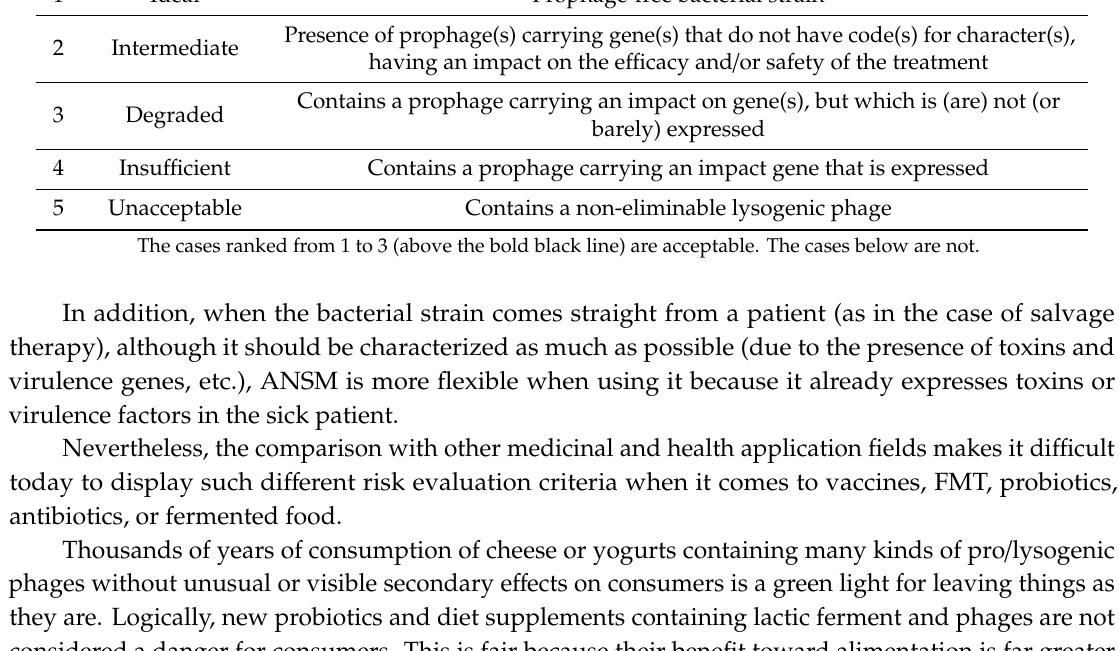
Table 2. Prophage management risk ranking, according to the French Regulatory Agency (ANSM). Case Type Risk Level 1 Ideal Prophage-free bacterial strain Presence of prophage(s) carrying gene(s) that do not have code(s) for character(s), 2 Intermediate having an impact on the e ffi cacy and / or safety of the treatment Contains a prophage carrying an impact on gene(s), but which is (are) not (or 3 Degraded barely) expressed 4 Insu ffi cient Contains a prophage carrying an impact gene that is expressed 5 Unacceptable Contains a non-eliminable lysogenic